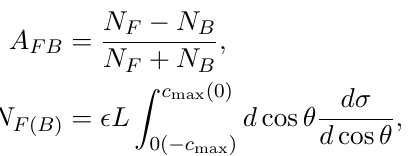
=g L - m Z =g R plane for e + e (cid:0) 2 3